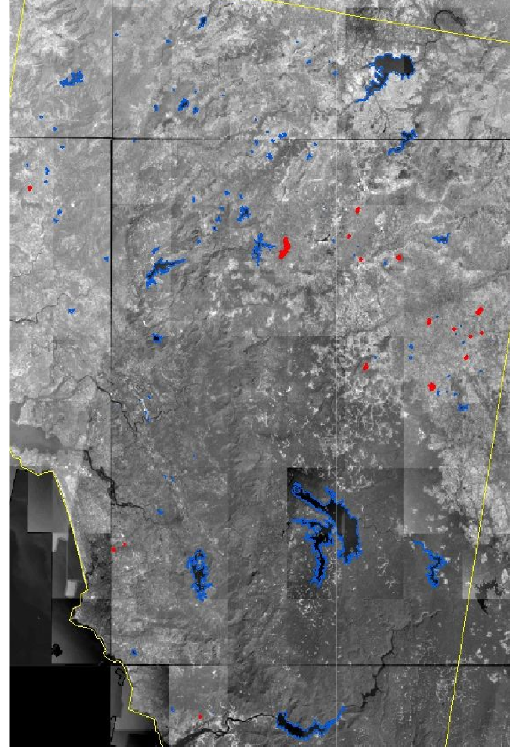
Figure 7. Cartosat-1 image with water bodies polygon were built between 1973 and 2011 Cartosat-1